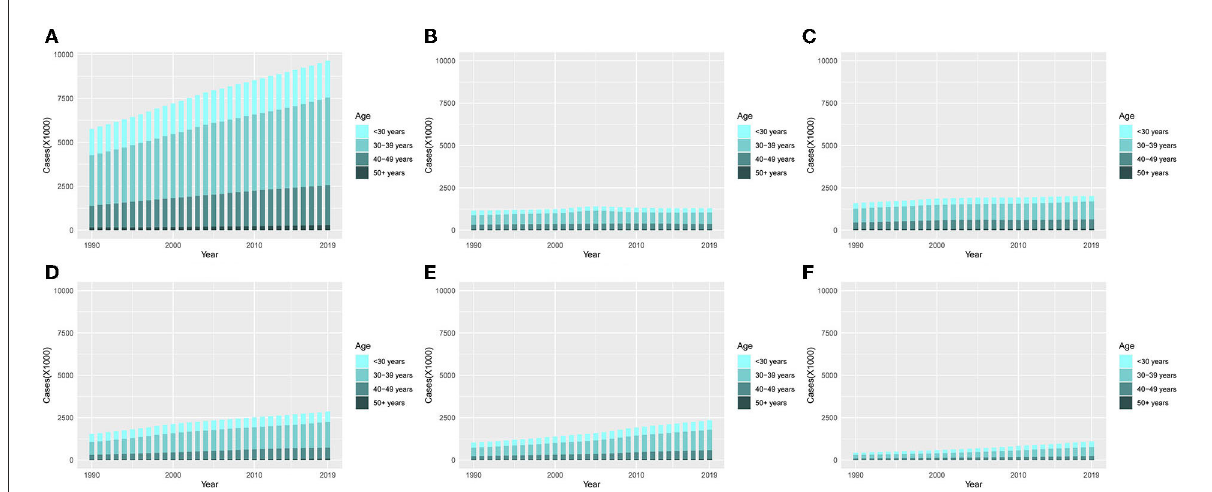
FIGURE6 The proportion of the four age groups for incidences of UFs between 1990 and 2019. (A) Global. (B) High SDI. (C) High-middle SDI. (D) Middle SDI. (E) Low-middle. (F) Low